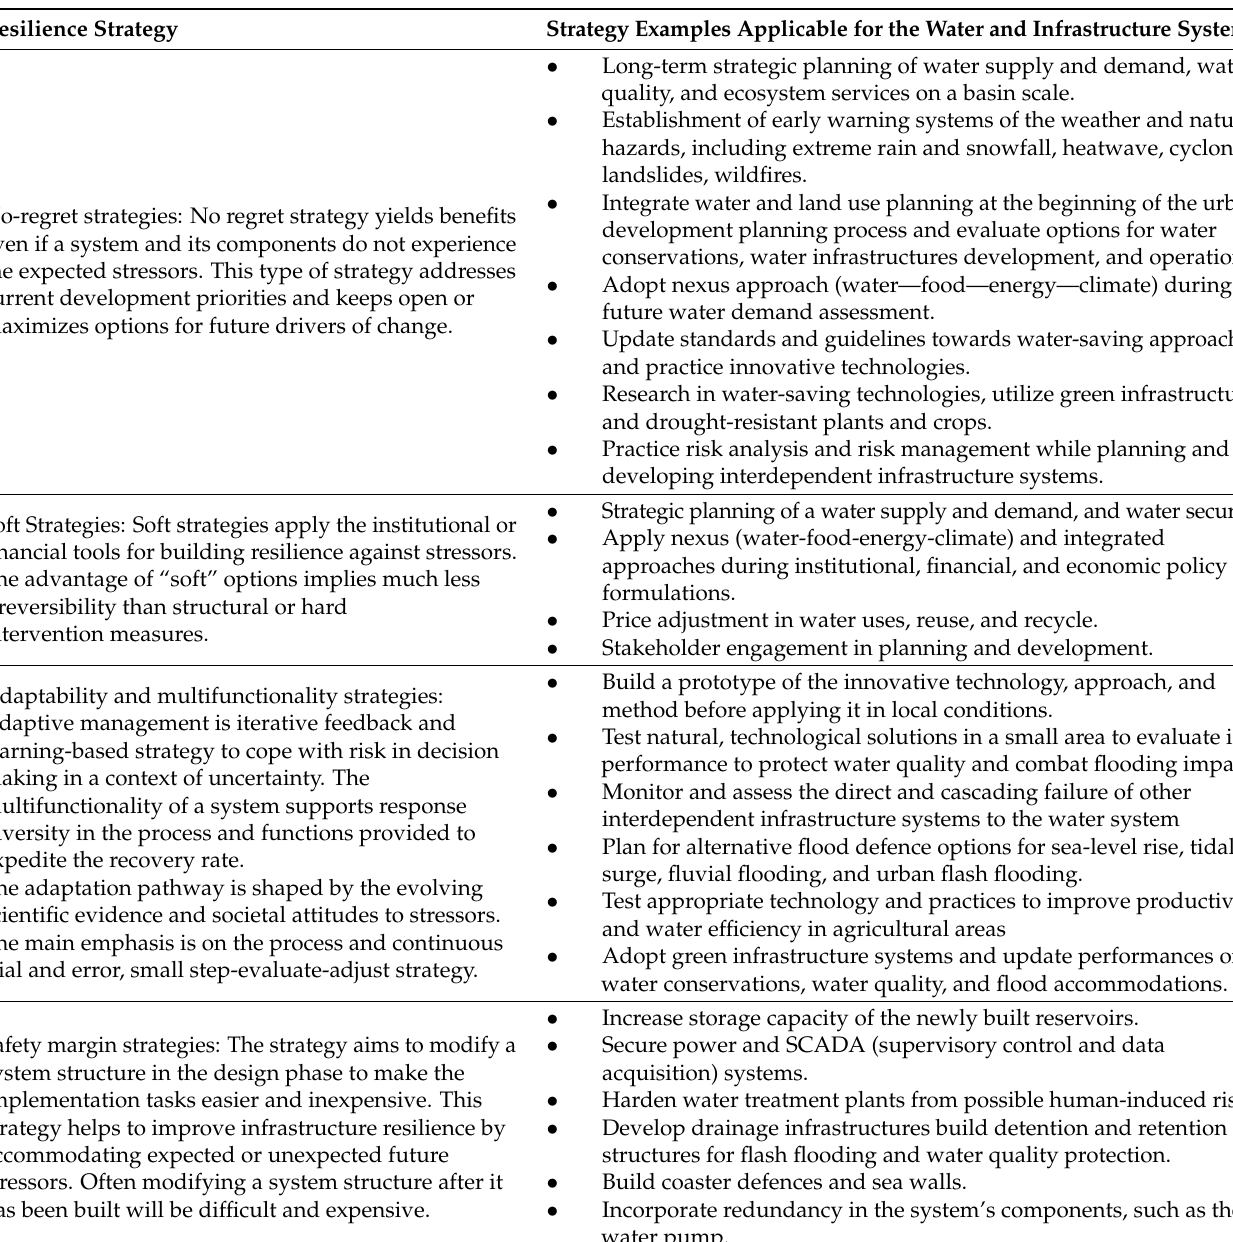
Table 4. Strategies for incorporating the resilience in water resources and infrastructure